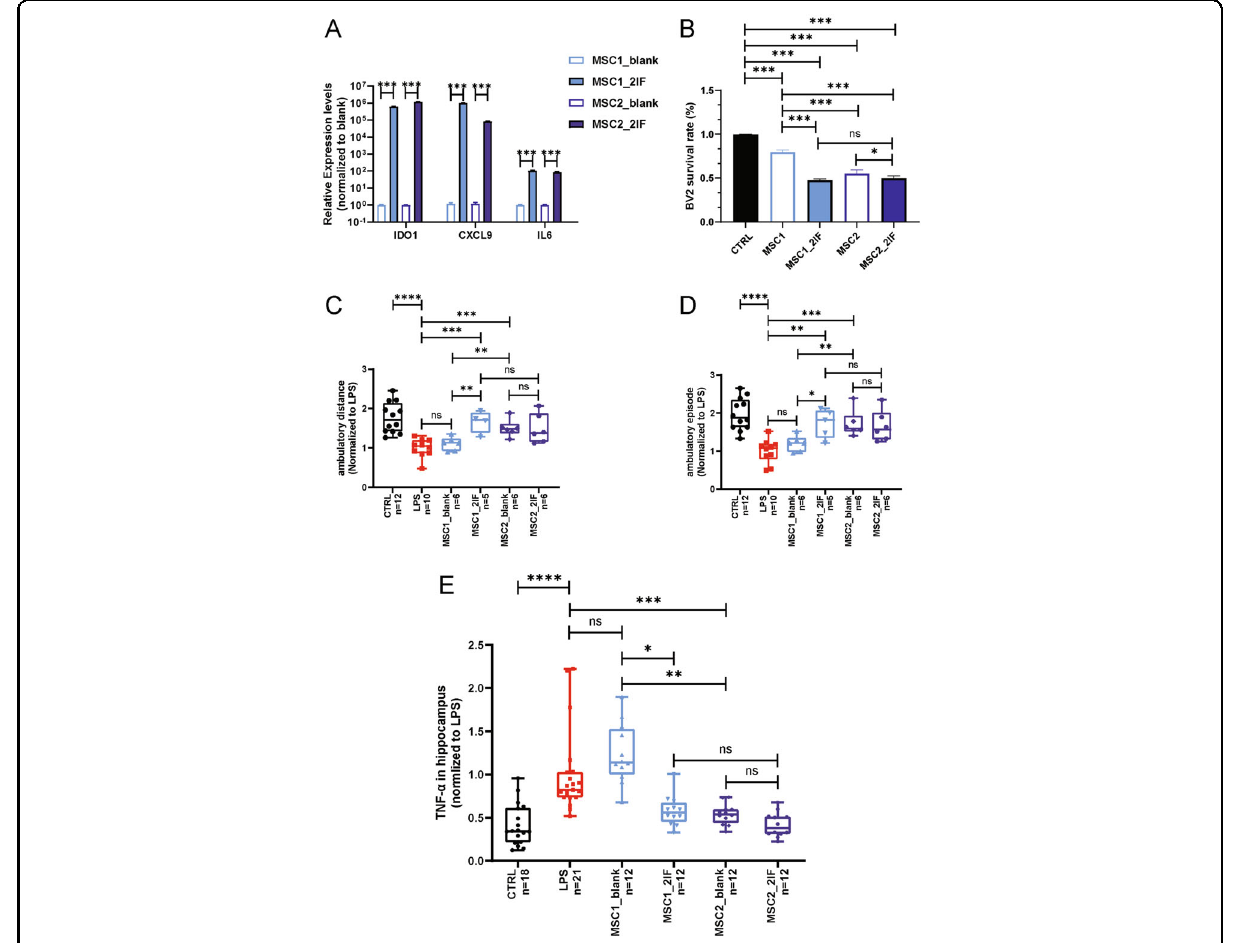
Fig. 4 Two-factor stimulation abolished donor-dependent variations of huMSCs in immune suppression. A Anti-in fl ammation genes IDO1 , CXCL9 and IL6 were extensively up-regulated in huMSCs by stimulation of TNF- α and IFN- γ (2-factors). B In vitro analysis on BV2 inhibition showed elimination of donor-dependent variations in immune-modulations by two factors. C – E eradication of speci fi c donor-dependent variations of huMSCs regarding treatment ef fi cacies in LPS-induced neuroin fl ammation model, by open- fi eld-motor scoring and hippocampal TNF- α expression. All data were normalized to LPS group, and were presented as mean ± SEM, * p < 0.05, ** p < 0.01, *** p < 0.001, **** p <